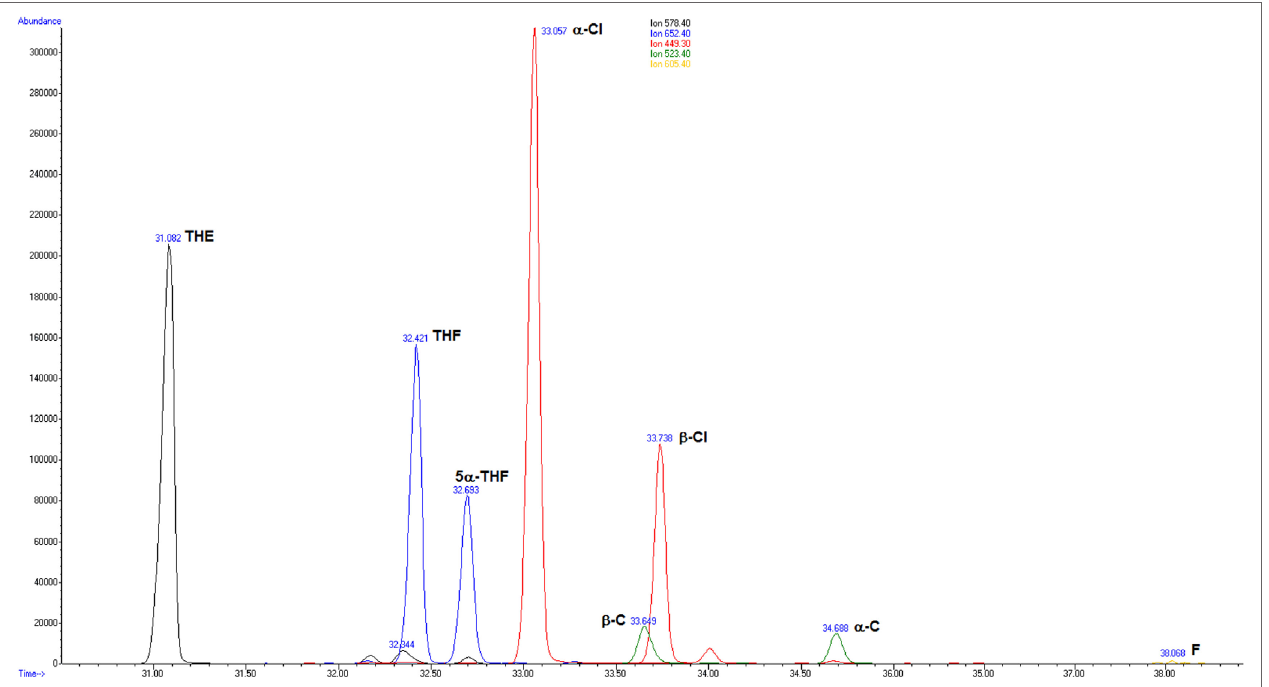
FigUre 1 | Merged extracted ion chromatograms for the glucocorticoids measured in the urine of a male proband on duty: m / z (mass to charge ratio) 578.4 tetrahydrocortisone (THE); m / z 652.4 tetrahydrocortisol (THF) and 5 α -tetrahydrocortisol (5 α -THF); m / z 449.3 α -cortolone ( α -Cl) and β -cortolone ( β -Cl); m / z 523.4 α -cortol ( α -C) and β -cortol ( β -C); and m / z 605.4 cortisol